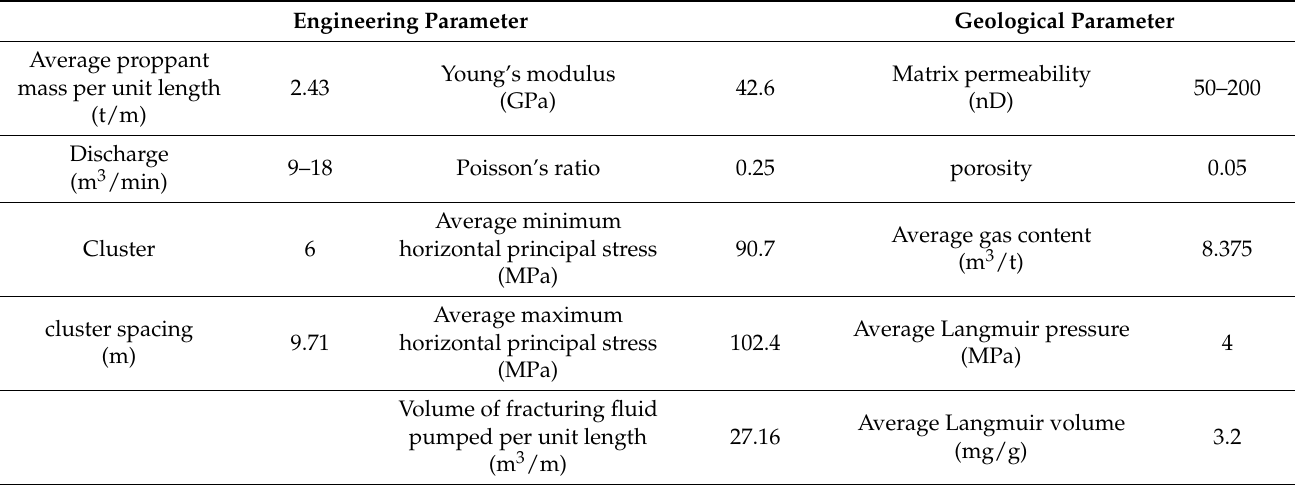
Table 1. The basic parameters for numerical